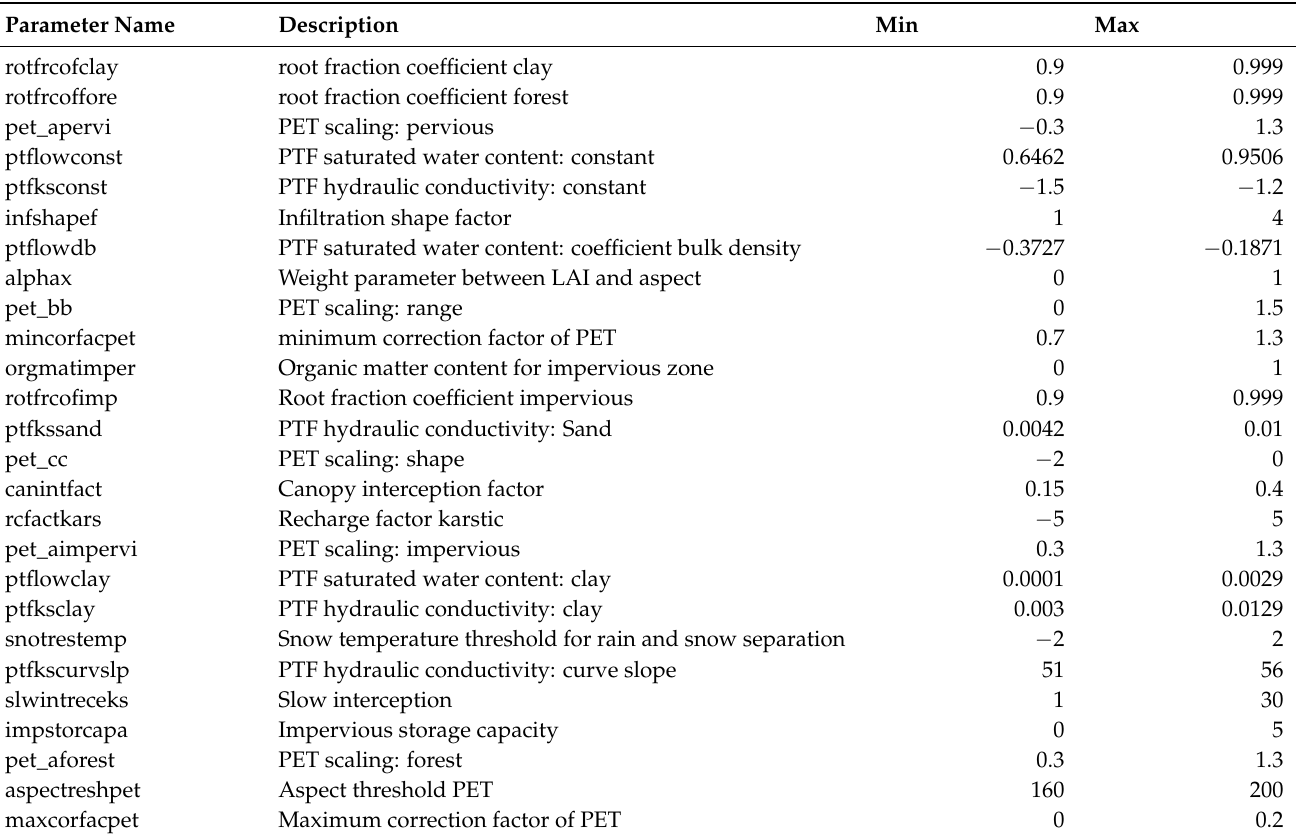
Table 2. Description of twenty-six selected sensitive parameters and their ranges in